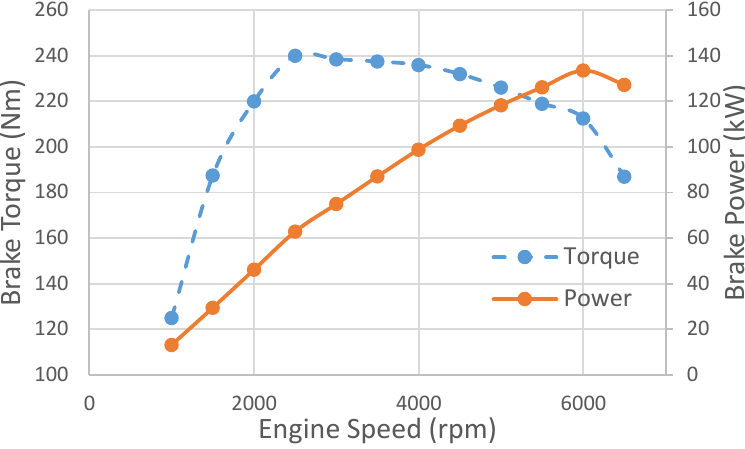
Figure 7. Performance of the based turbo-charged engine.